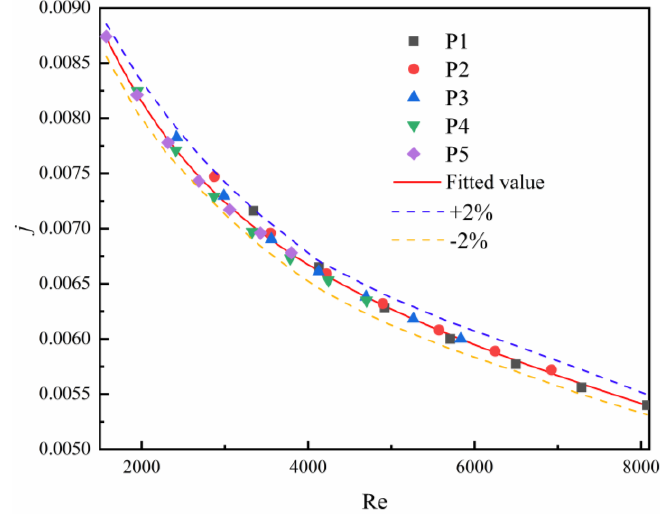
Figure 24. Distributions of factor j versus different Reynolds numbers and Prandtl numbers.